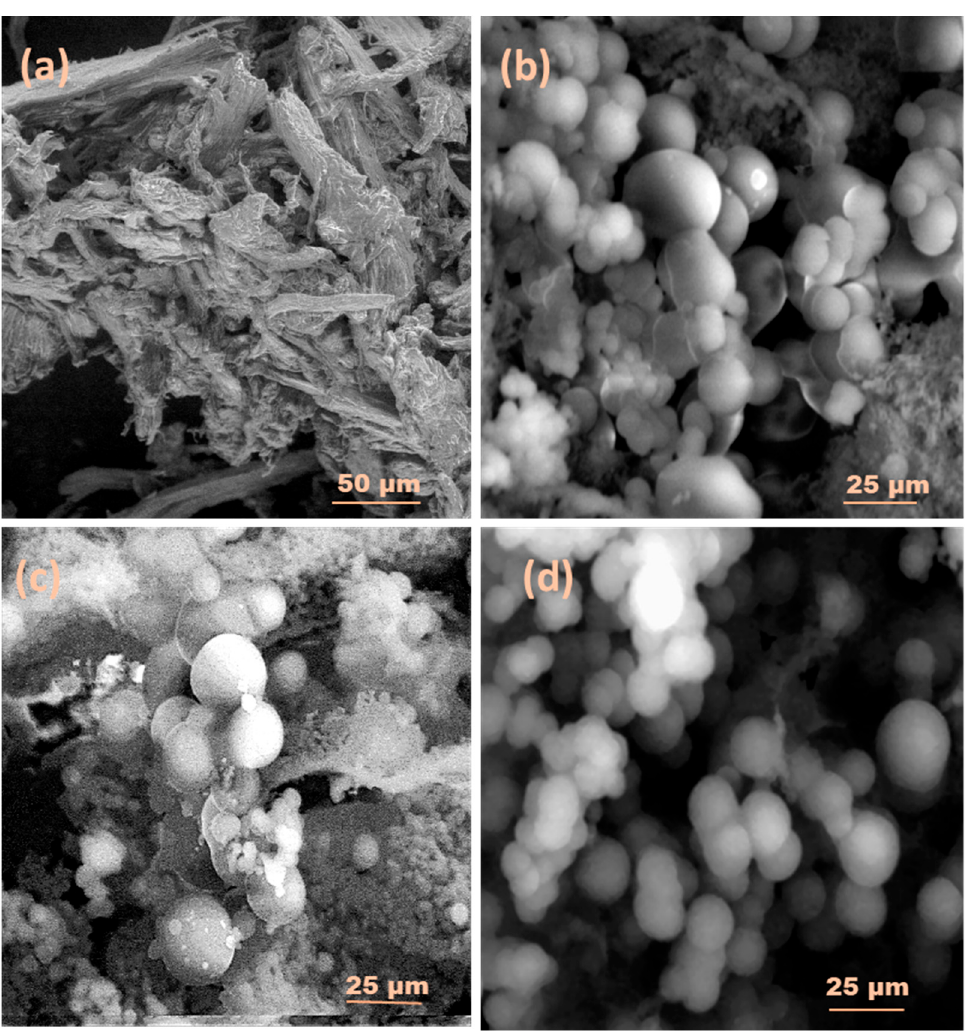
Figure 3. SEM images of ( a ) Raw Dimocarpus longan peel powder (LFP) and their corresponding carbon micro-spheres ( b ) LFP-200, ( c ) LFP-250, and ( d ) LFP-300 produced at various temperatures. The HC extracted from the LFP powder was fibrillated. The entire skeleton of the extracted HC was covered by carbon microspheres of varying sizes. The proportion of these carbon microspheres increased successively with a growth in temperature from 200 ◦ C to 300 ◦ C during the HTC process (HC-200, HC-250, and HC-300). Compared to LFP-based carbon samples, the number of carbon microspheres in HC-based samples was greater. Furthermore, the sizes of the carbon microspheres were comparatively smaller for HC-based samples. This clearly reflected the presence of lignin in LFP, which made it more difficult to be carbonized completely in comparison with the HC, which contained only a mixture of cellulose and